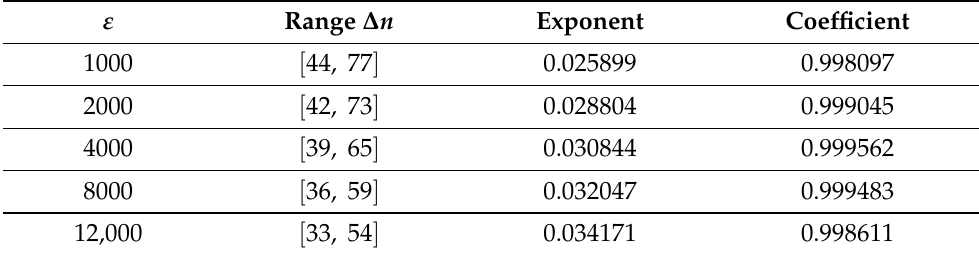
Table 9. Maximal Lyapunov exponents for coop1 (differences).